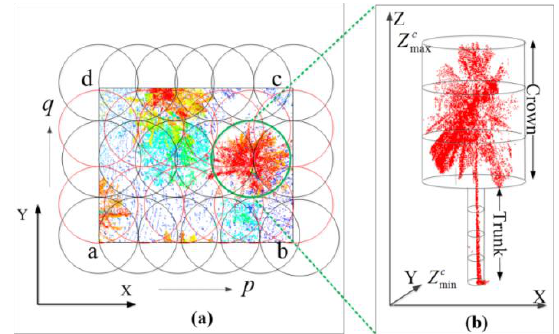
Figure 1. (a) Cylindrical region growing (b) tree